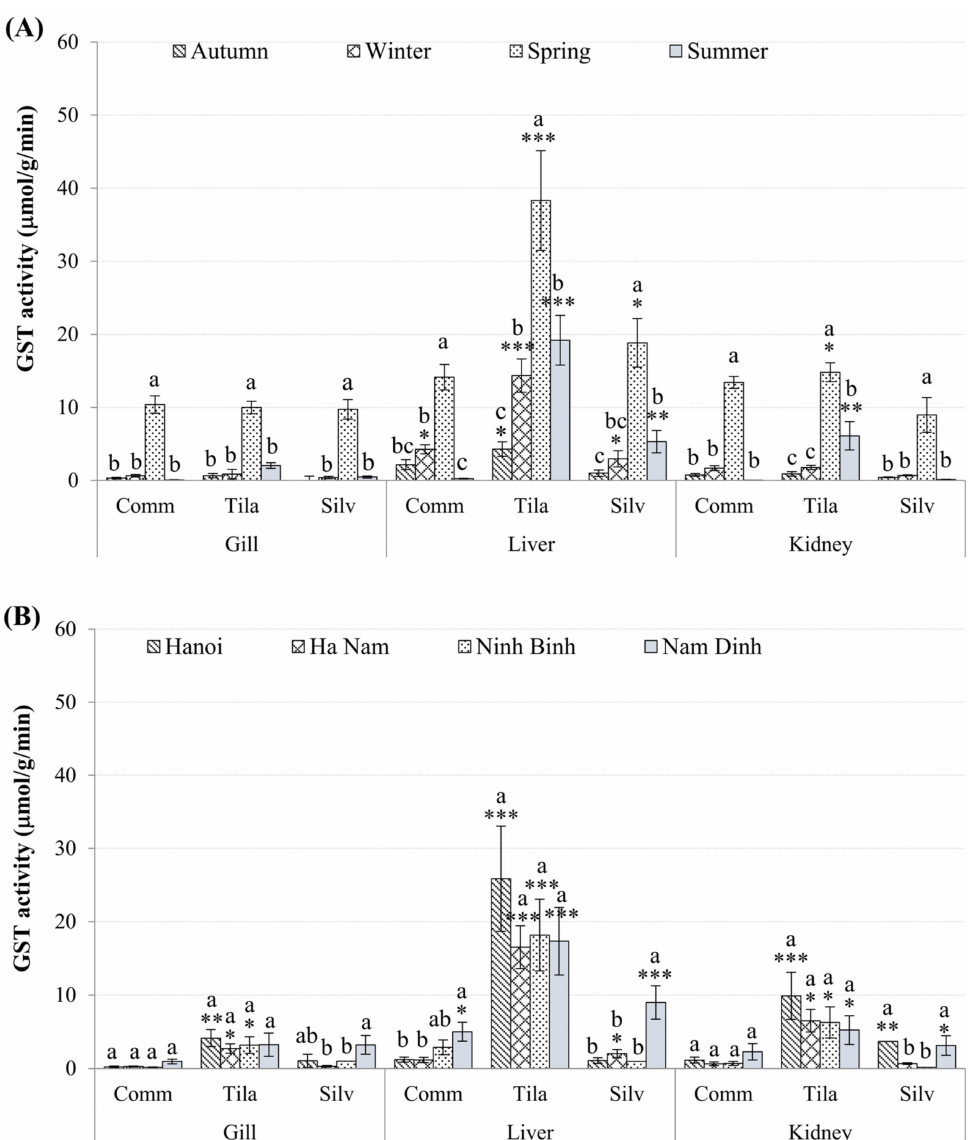
Figure 3. Seasonal ( A ) and spatial ( B ) variation in GST activities (mean ± SEM) in tested tissues of C. carpio (Comm), H. molitrix (Silv), and O. niloticus (Tila) from selected sampling sites. Significant differences in GST levels, of all tissues of three fish species, between sampling times ( A ) and sites ( B ) in comparison to the lowest value (*) are shown (mean ± SEM, n = 10–20, * p < 0.05, ** p < 0.01; *** p < 0.001). Different letters (a > b > c) indicate that the variation of GST values between seasons ( A ) or between locations ( B ) within the same organ type is significant ( p < 0.05; ANOVA followed by Tukey–Kramer multiple comparisons